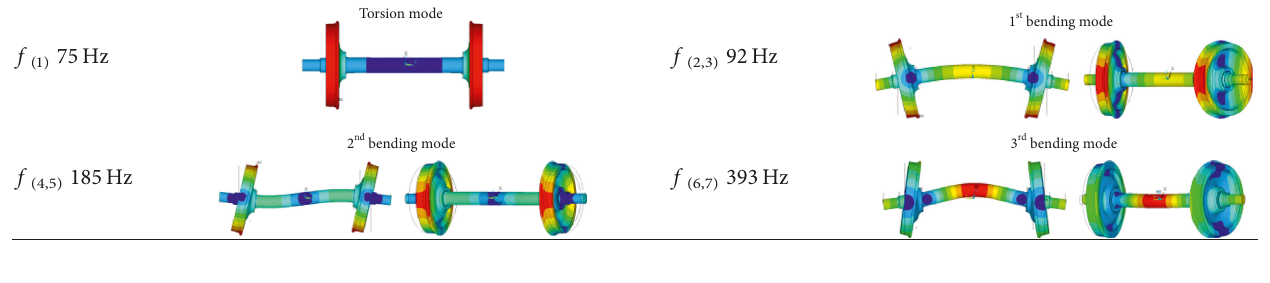
Table 2: Modes of wheelset.